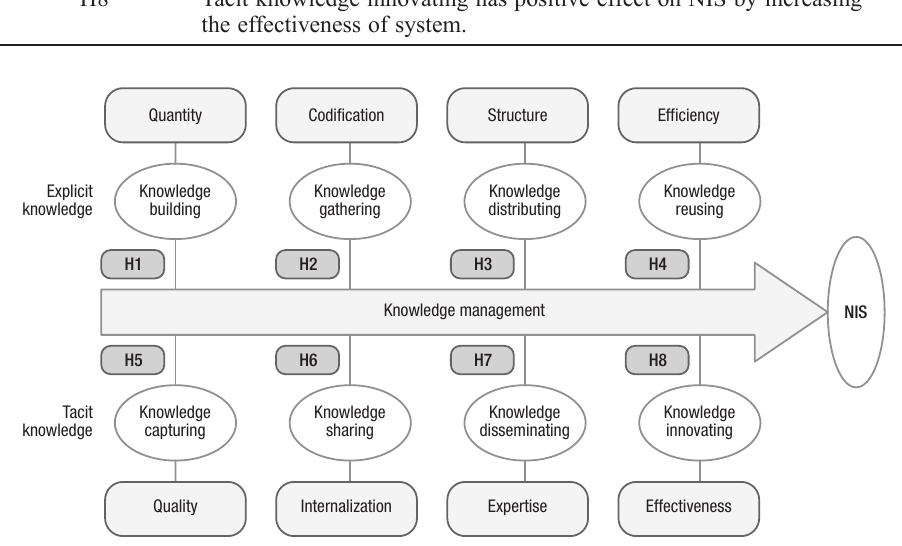
Fig. 1. Model of NIS enabled by